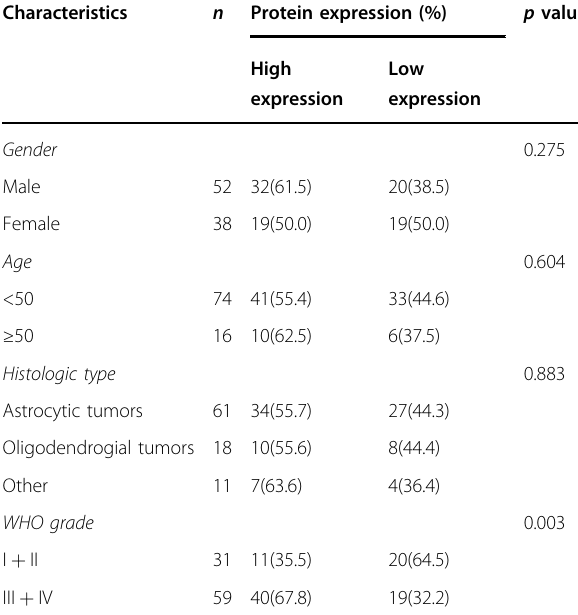
Table 2 Association between the clinicopathologic characteristics and the P75CUX1 protein expression in